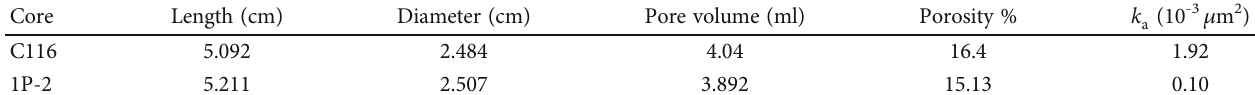
Table 2: Dimensions, porosities, and permeabilities of the two core samples.